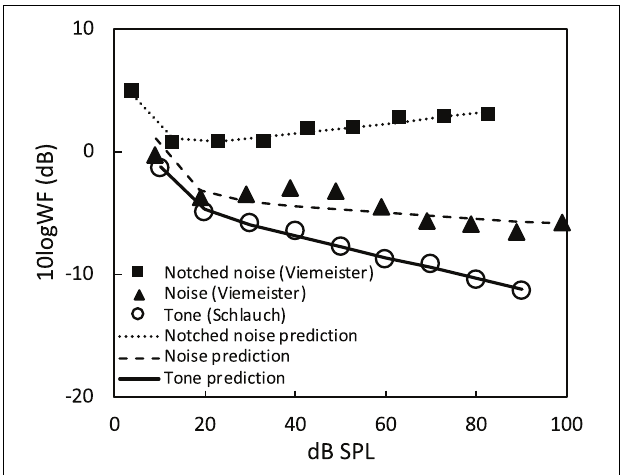
FIGURE 4 | Prediction of JND for noise and tone stimuli. The JND data for a broadband noise (solid triangles) and the same noise in a notched-noise background (solid squares) were from Viemeister (1983; the same symbols in his Figure 1 ) and the 1000-Hz tone JND data (open circles) were from Schlauch et al. (1995; circles in their Figure 2 bottom-right panel). The dashed line represents prediction of the noise JND function, the dotted line represents the noise in a notched-noise background, and the solid line represents the tone JND